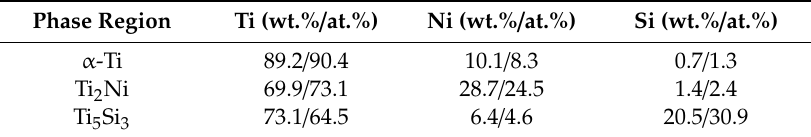
Figure 2. ( a ) SEM image and ( b ) XRD pattern of the Ti10Ni5Si alloy. Table 2. Chemical compositions of the alloy determined by Table 2. Chemical compositions of the alloy determined by EDS.